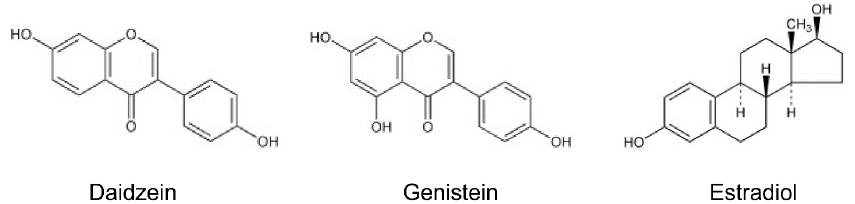
Table 1. Approximate content of isoflavones in main sources.